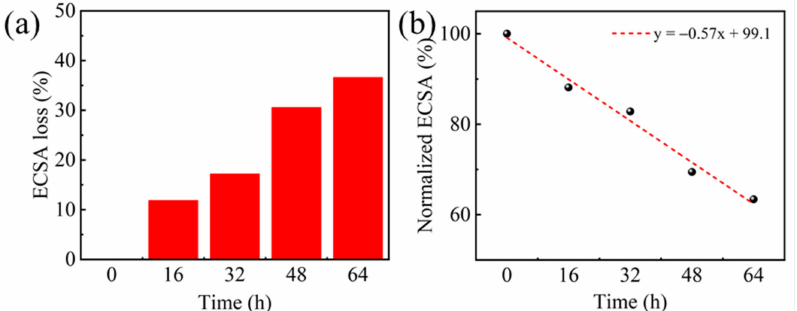
Figure 6. ( a ) Normalized ECSA loss measured during the 64 h test; ( b ) Linear fitting of normalized ECSA loss with operation